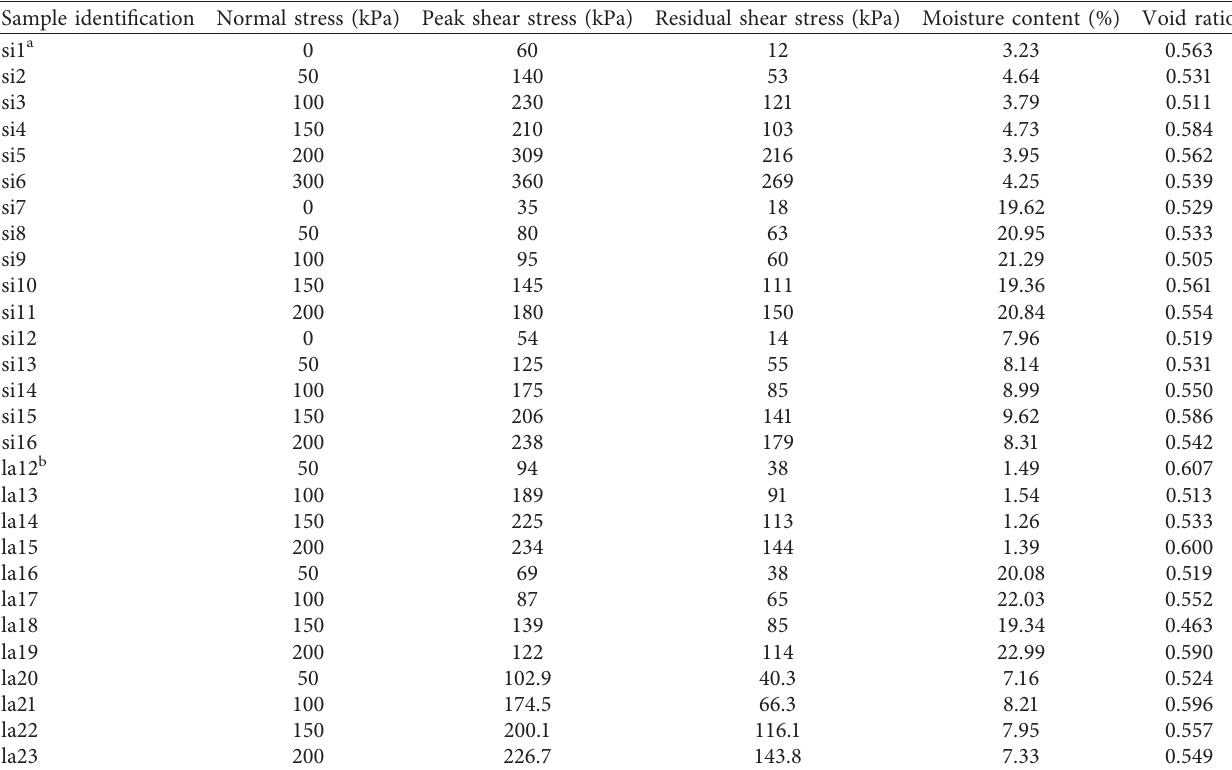
Table 2: Details of the in situ and laboratory direct shear tests.